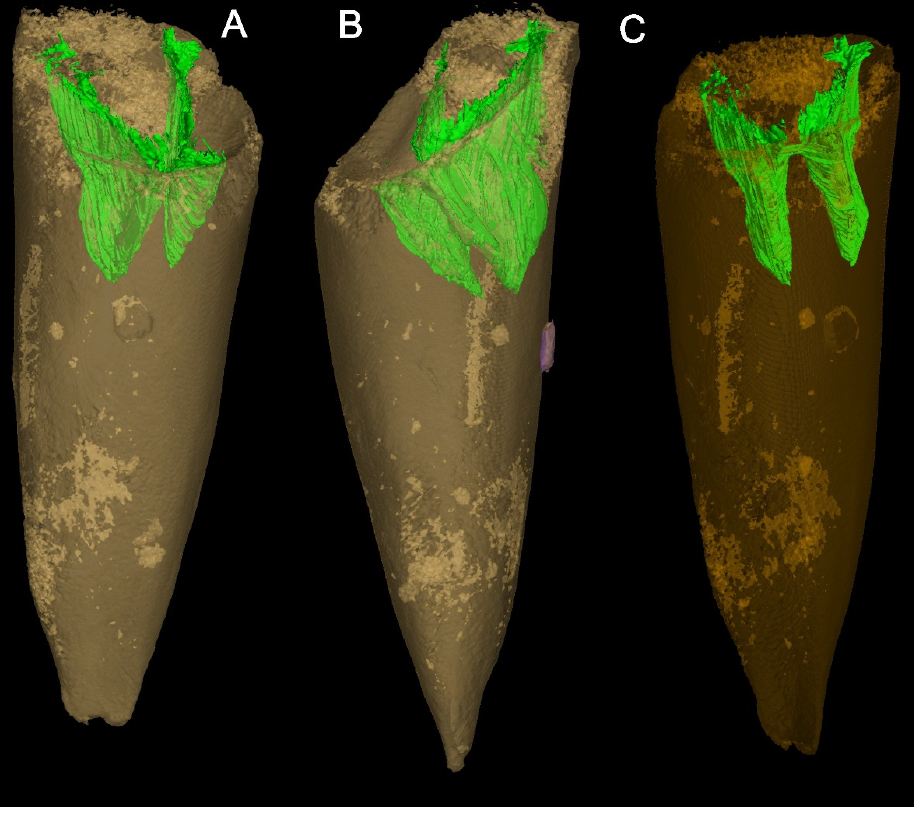
Figure 4. Reconstruction of Doliutheca orientalis from Micro-CT analysis (semi-transparent model), showing the 3D mold of platy clavicles (green) in the steinkern. ( A , C ), dorsal view; ( B ), lateral view. The purple part is the potential borehole.